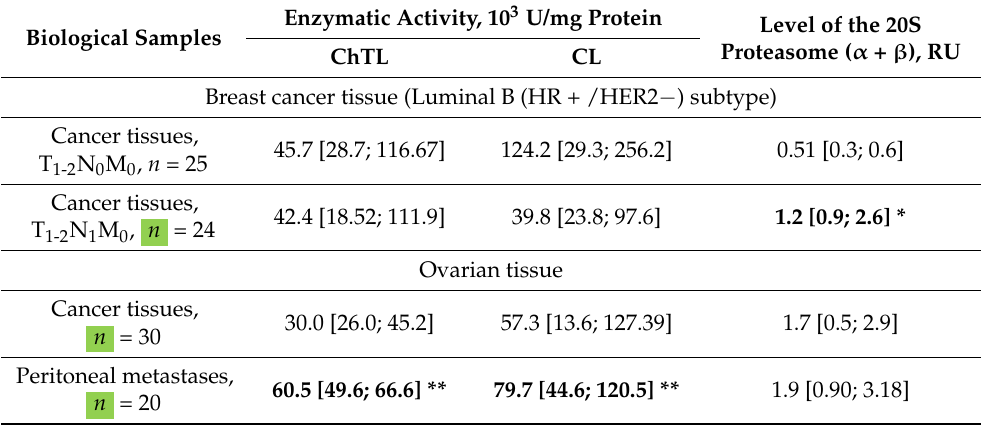
Table 2. Relationship of the proteasomal activity and level of 20S proteasome in luminal B-like (HR + /Her2 − ) breast cancer and ovarian cancer tissues with lymphogenic and peritoneal metastasis.